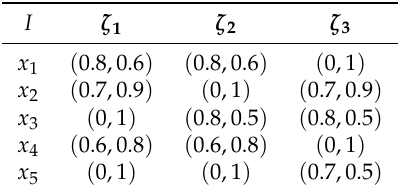
Table 3. Incidence matrix of